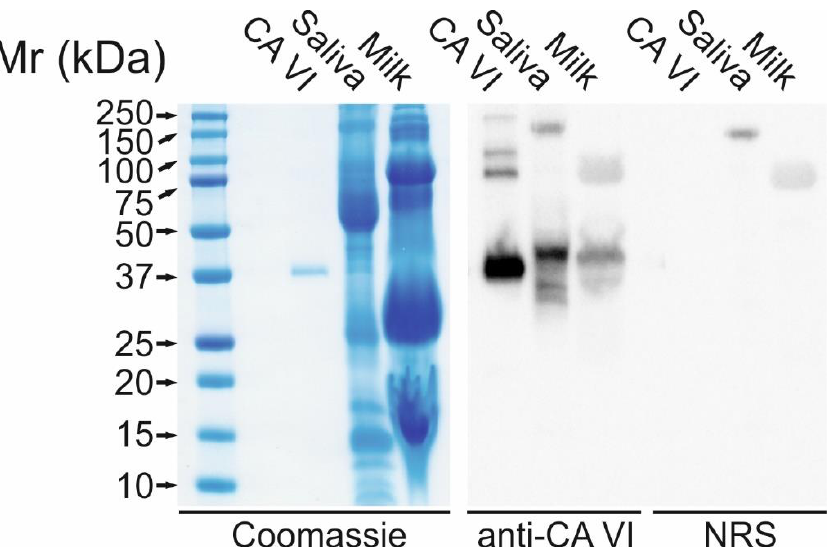
Figure 1. SDS-PAGE and Western blot of purified human CA VI (0.5 ug), saliva (10 uL), and milk (10